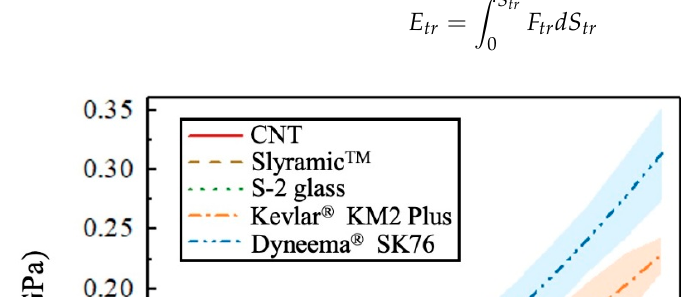
Figure 13. Comparison of energy dissipation of different fibers.